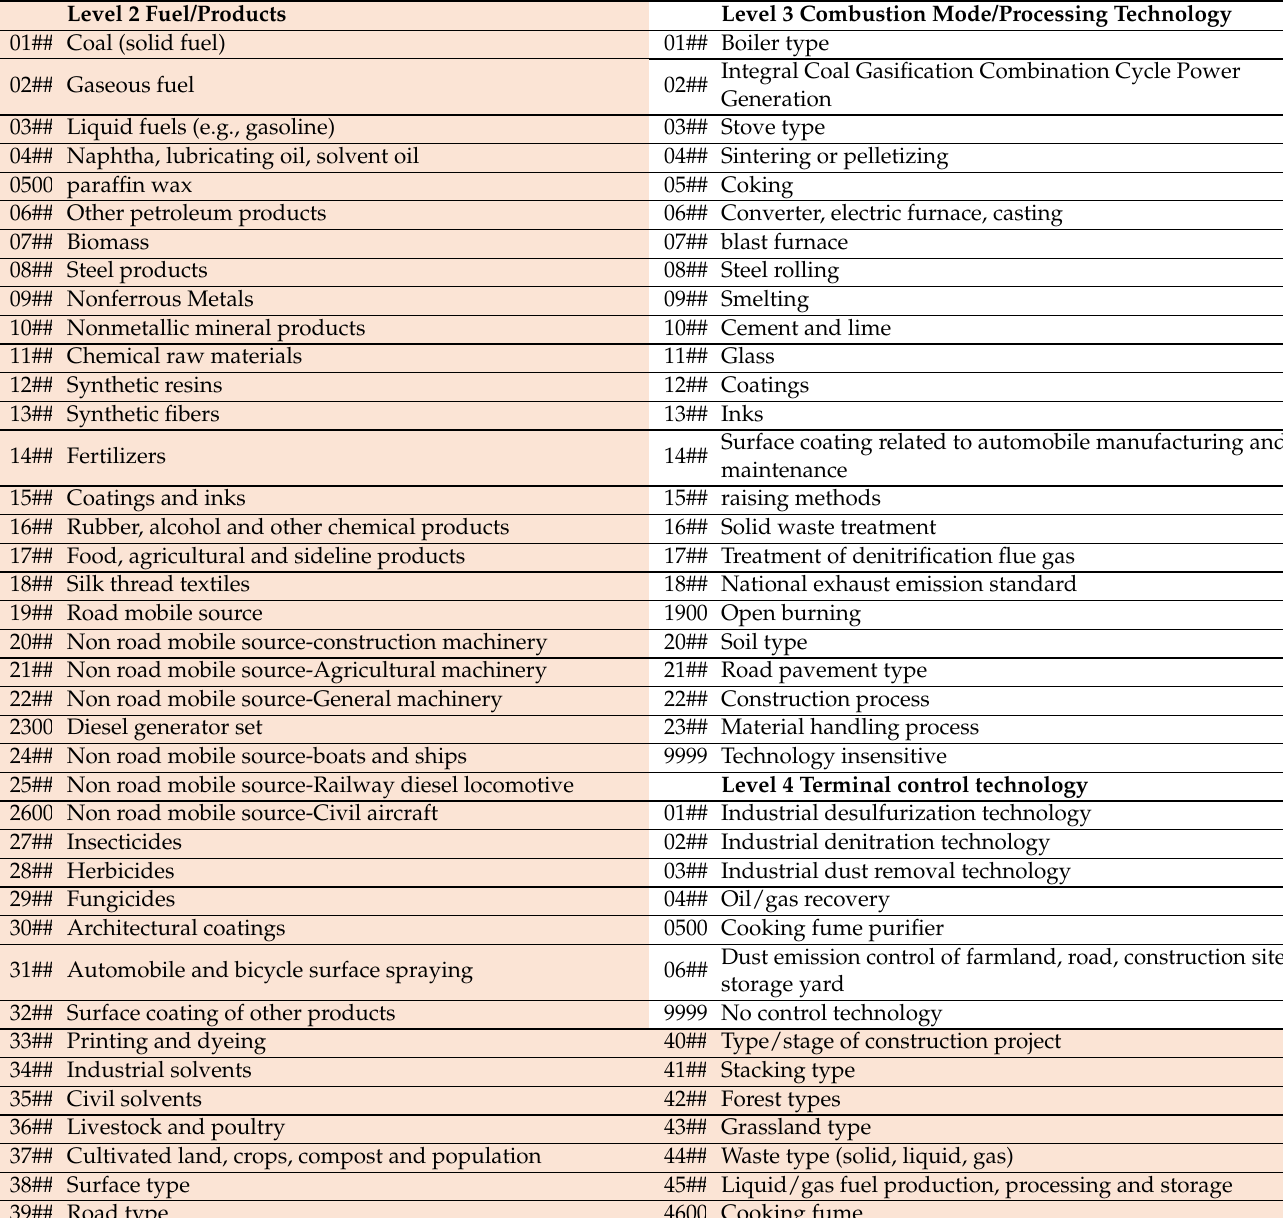
Table 3. Leveled codes for categories and subcategories of air pollutant emission sources.